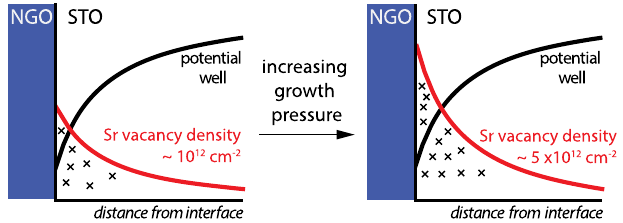
FIG. 7. Schematic of the defect structure at the NGO/STO interface for different p based on low-temperature electron dep mobility and carrier density. The shape of the potential well is assumed to be similar in both cases, while the density of defects increases with increasing p . In particular, the concentration of dep cation vacancies increases for higher p , mediated by the dep Schottky